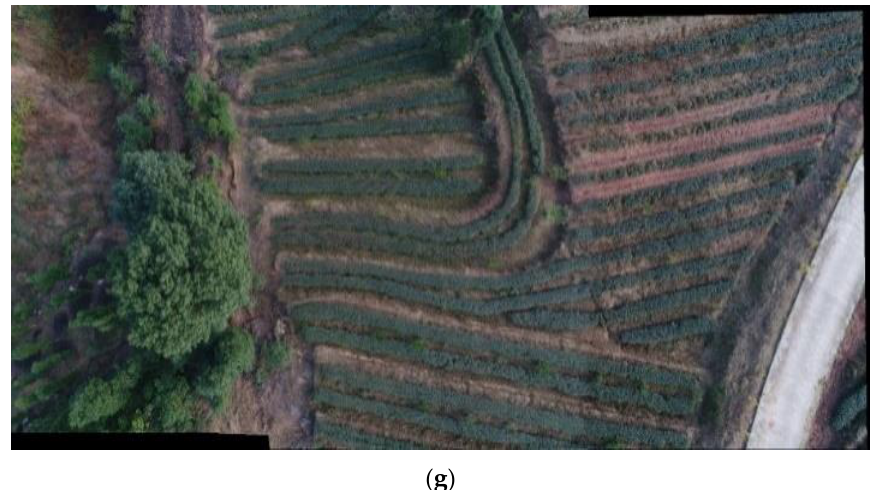
Figure 8. Tea garden image registration by the AANAP algorithm. ( a ) Reference image; ( b ) target image; ( c ) image with extracted feature points by the SIFT algorithm; ( d ) image with selected feature points; ( e ) mesh division and deformation; ( f ) image transformation result; and ( g ) results by the AANAP algorithm.